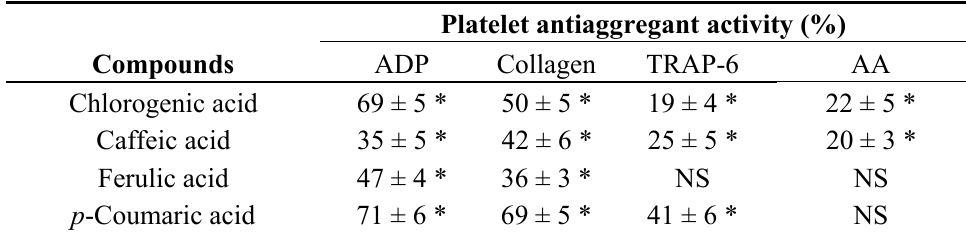
Table 2. Antiplatelet activity of phenolic